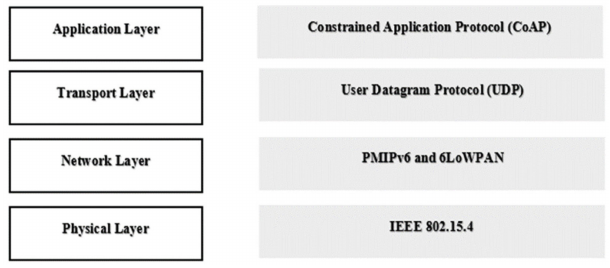
Figure 3. Protocol stack of proposed PB-PMIPv6 for IoT.